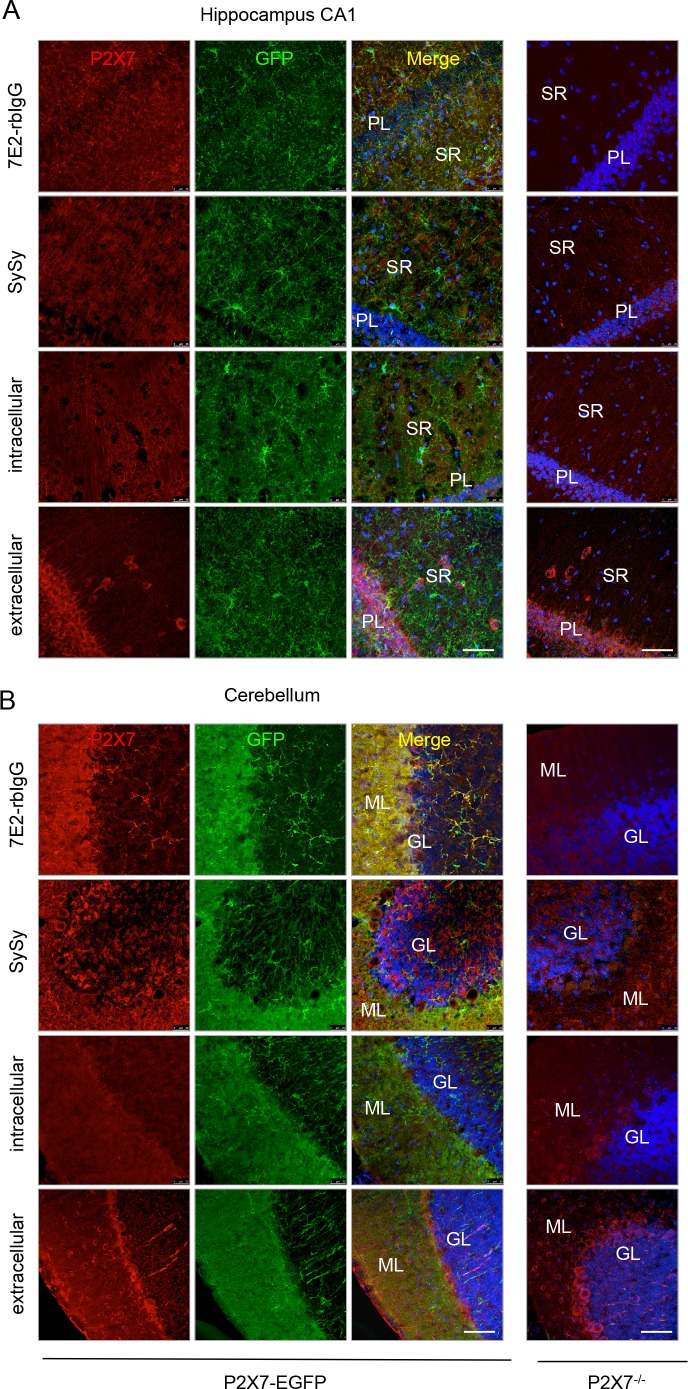
Comparison of the specificity of commercially available anti-P2X7 antibodies and an anti-P2X7 nanobody-rbIgG heavy chain antibody (7E2-rbIgG) in CA1 (A) and cerebellar (B) slices of adult line 17 mice and P2X7-/- mice.GL, granular layer; ML, molecular layer; PL, pyramidal cell layer; SR, stratum radiatum. Representative stainings are shown for the P2X7-specfic 7E2-rbIgG, the Synaptic Systems antibody and two Alomone antibodies directed against intra- and extracellular epitopes, respectively (n = at least 3, each). Scale bars: 50 μm.